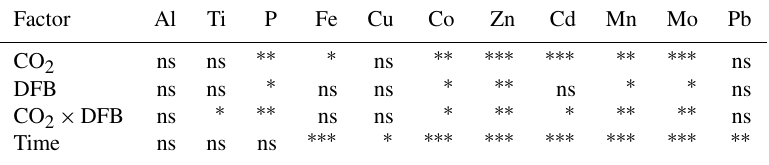
Table 1. Statistical analyses (split-plot ANOVA) of the effects of high CO 2 , the addition of DFB and their interaction, as well as the effect of time, on the concentrations of particulate metals (nmolL − 1 ; see data in Table S2 and Fig. 1) in particles collected from the different mesocosm treatments. We used all of the days for the analyses because the split-plot ANOVA integrates fixed factors (CO 2 and DFB) and a repeated measures factor (time) by using the post hoc Bonferroni test, thus time was fully considered during the whole experimental period.